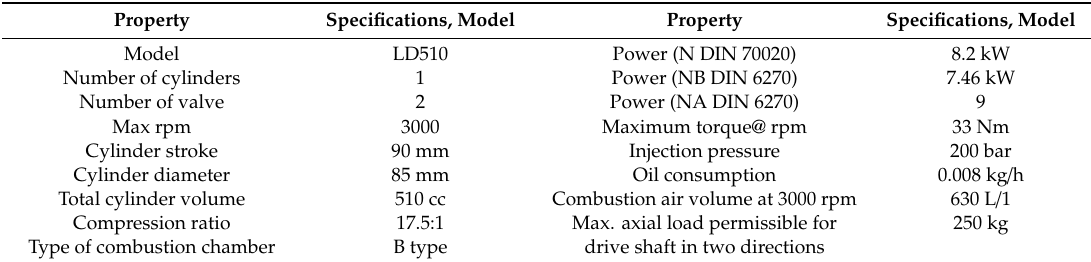
Table 2. Specifications of the 3LD510LOMBARDINI